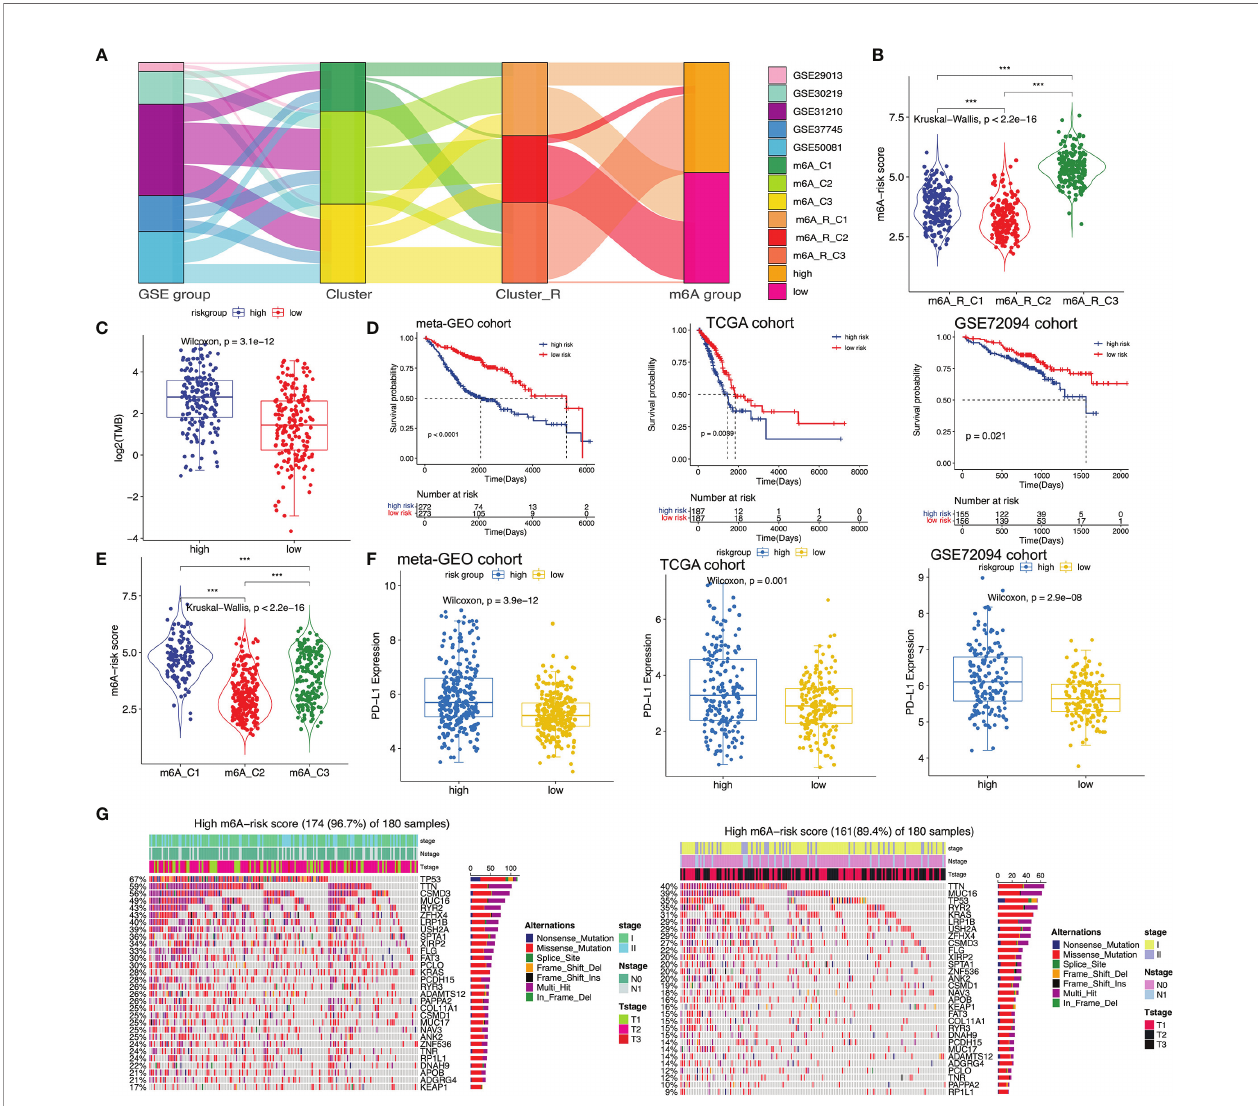
FIGURE 4 | Establishment of m 6 A-predictive score and evaluation its correlated clinical landscapes. (A) Sankey diagram of different GSE groups with various m 6 A clusters, m 6 A cluster-Rs and m 6 A-predictive score. (B) Comparison of m 6 A-predictive score among three clusters in the meta-GEO cohort (*P < 0.05; **P < 0.01; ***P < 0.001). (C) Comparison of tumor mutation burden (TMB) between low and high m 6 A-score groups in TCGA cohort. (D) Kaplan-Meier curves of low and high m 6 A-score groups in meta-GEO, TCGA and GSE72094 cohorts via Log-rank test. (E) Comparison of m 6 A-predictive score among three clusters in the meta-GEO cohort (*P < 0.05; ** P< 0.01; ***P < 0.001). (F) Distribution of PD-L1 expression levels in different m 6 A-score groups of meta-GEO, TCGA and GSE72094 cohorts. (G) Mutational features of the top mutated genes in low and high m 6 A-score groups in the TCGA cohort. The sample annotations were shown in the upper part of the diagram, including stage, Tstage and